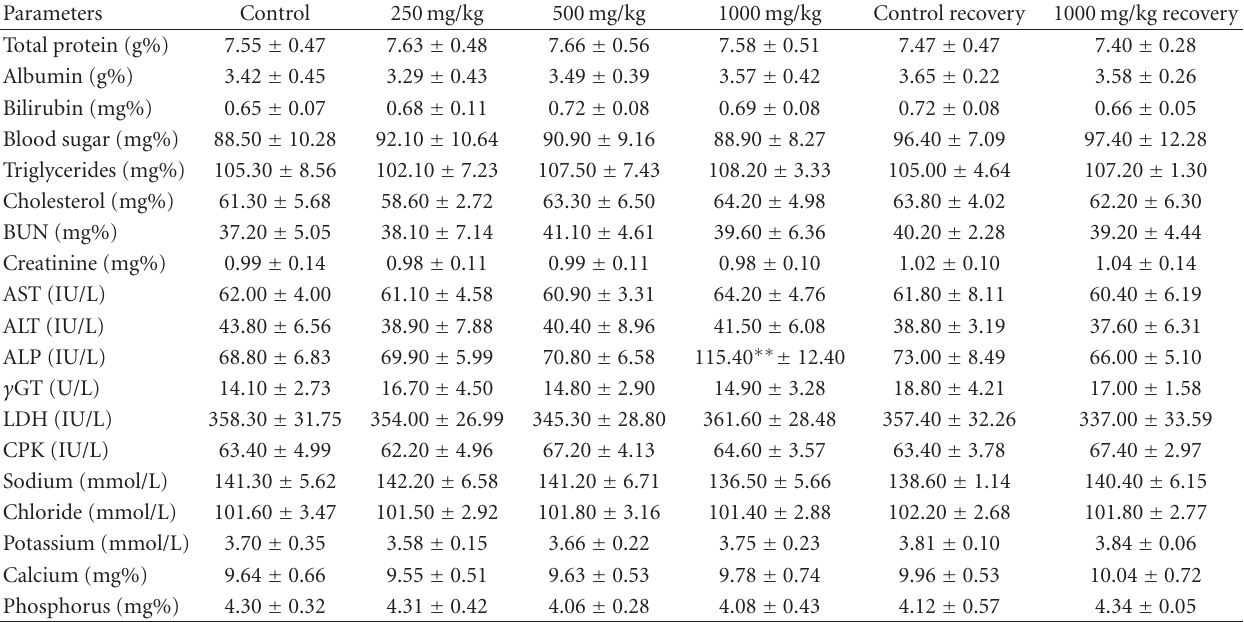
Table 4: Clinical chemistry data (mean ± SD) of male rats after oral administration of Zigbir (cid:2) for 90 days.